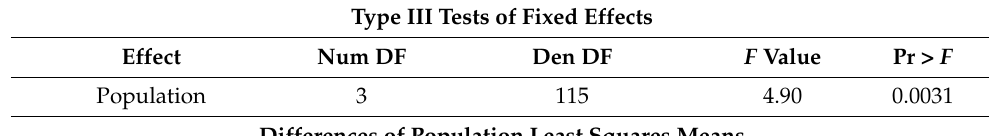
Table A16. 2020 Four Population Filled Seed